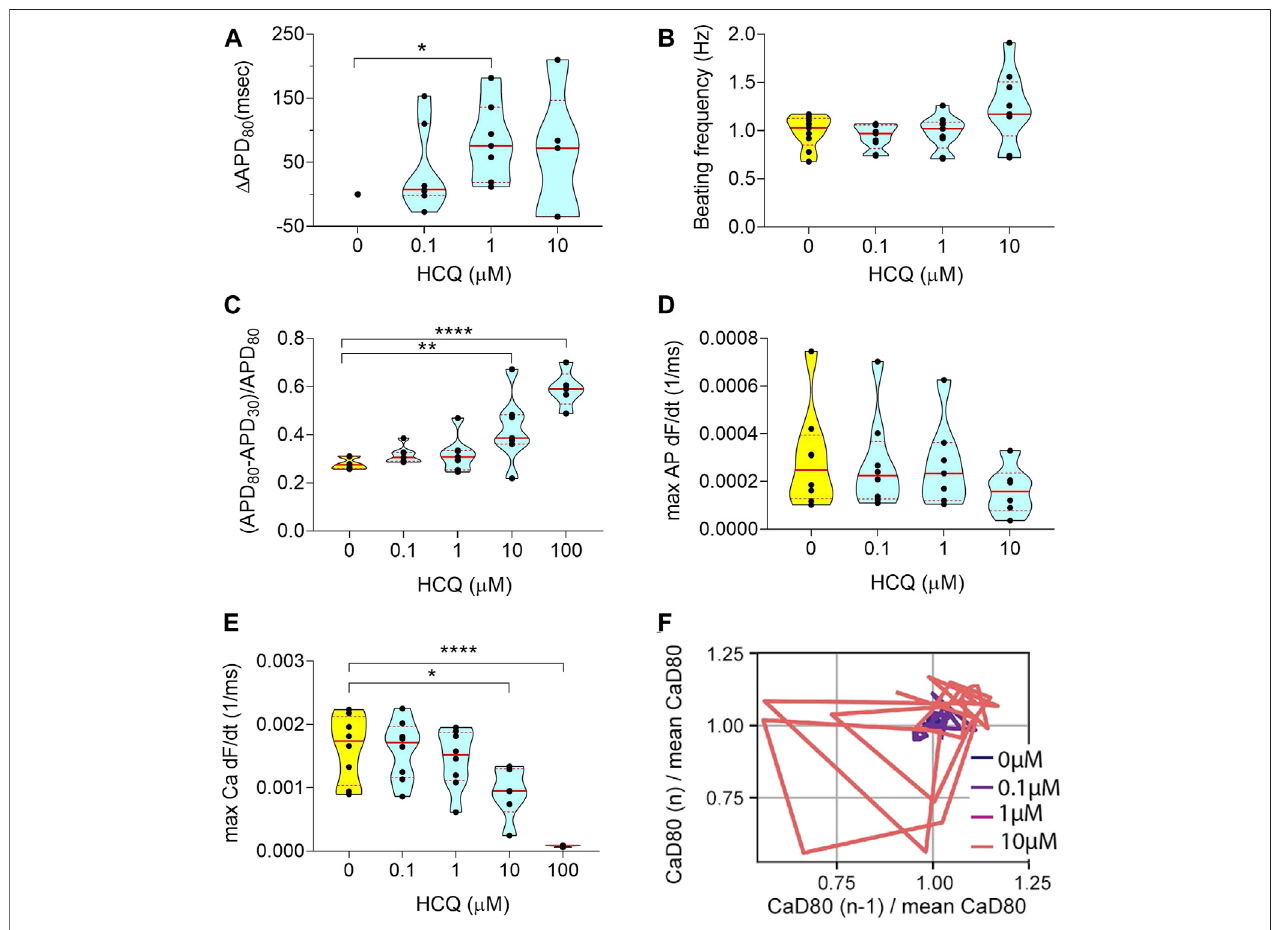
FIGURE 2 | Electrophysiology analysis of acute HCQ exposure. (A) Violin plot depicting the change in APD 80 in paced tissues over increasing doses (100 μ M was notshown,duetopoorsignalquality).Valueswerenormalizedtobaseline0 μ Mofeachtissuechamber. (B) GraphshowingspontaneousbeatingfrequencyinHz,forup to10 μ MHCQ. (C) Triangulationvaluesofspontaneous action potential traces. (D) Violinplotshowingtheactionpotentialmaximum upstrokevelocity,calculatedasthe maximumoftheupstrokeslopeofpacedtraces.The100 μ Mdatawerenotshowndue topoorsignalquality. (E) Graphdescribing themaximumupstrokevelocity of paced calcium transient traces. (F) Representative Poincaré plot showing instabilities in calcium transient duration in response to increasing HCQ doses (data from spontaneous traces). All tissues analyzed were within inclusion criteria of APD 80 < 500 ms at baseline. Statistics run were one-way ANOVA with multiple comparison